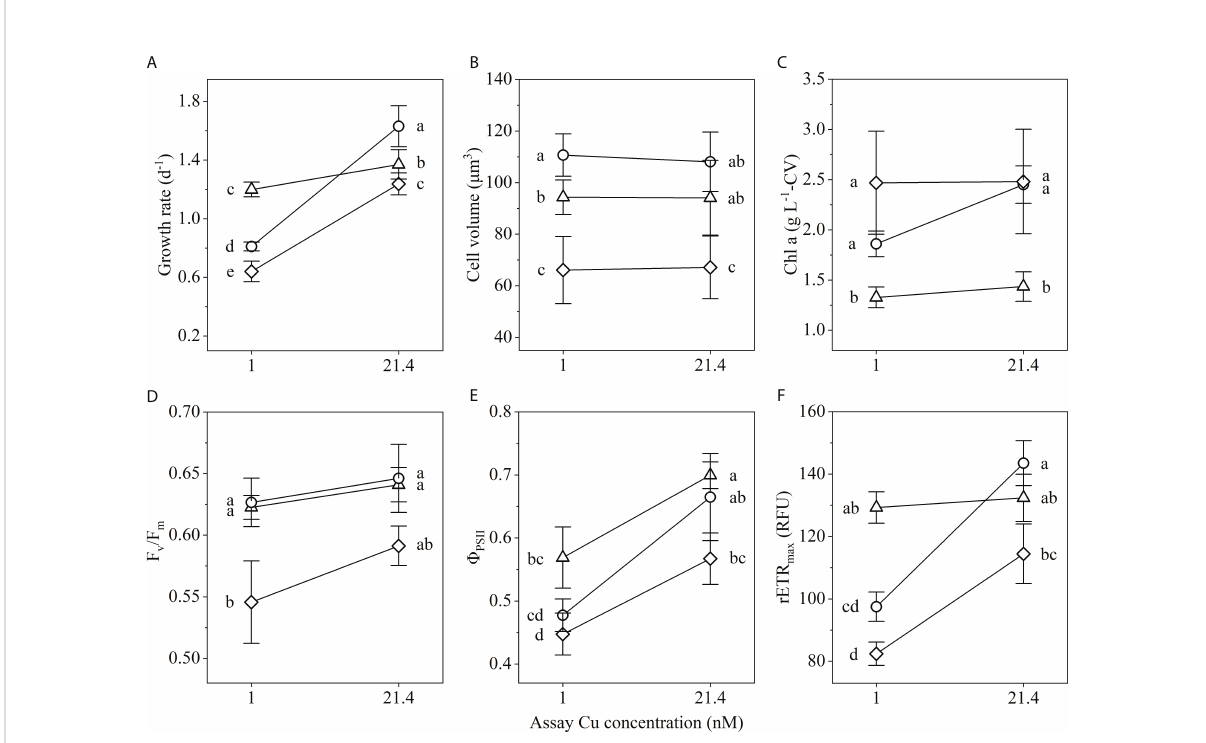
FIGURE 3 Physiological traits of LCuA 1nM ( △ ), CCuA ( ○ ) and ancestral ( ♢ ) populations in Cu-de fi cient and Cu-suf fi cient medium: (A) speci fi c growth rate, (B) cell volume, (C) cell volume-normalized chlorophyll a , (D) maximum quantum yield of photosystem II (F v /F m ), (E) effective quantum yield of photosystem II ( F PSII ) and (F) maximum relative electron transport rate (rETR max ). Error bars represent ±1 SD of three to fi fteen biological replicates (n=10-15 for A and B; n=3 for C-F). Different lowercase letters indicate a signi fi cant difference among traits of the populations (p<0.05, one-way